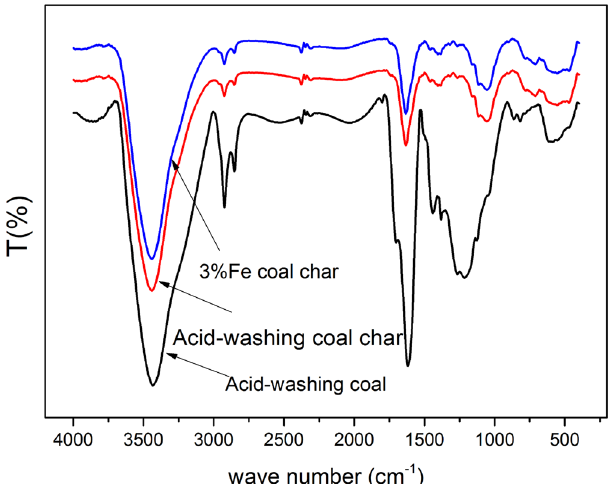
Figure 1. FT-IR spectrum of acid-washing coal and coal